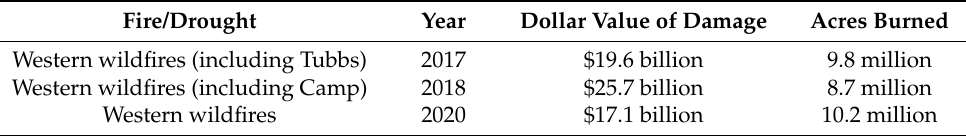
Table 1. Estimate of Damage from Recent Fires. Fire/Drought Year Dollar Value of Damage Acres Burned Western wildfires (including Tubbs) 2017 $19.6 billion 9.8 million Western wildfires (including Camp) 2018 Western